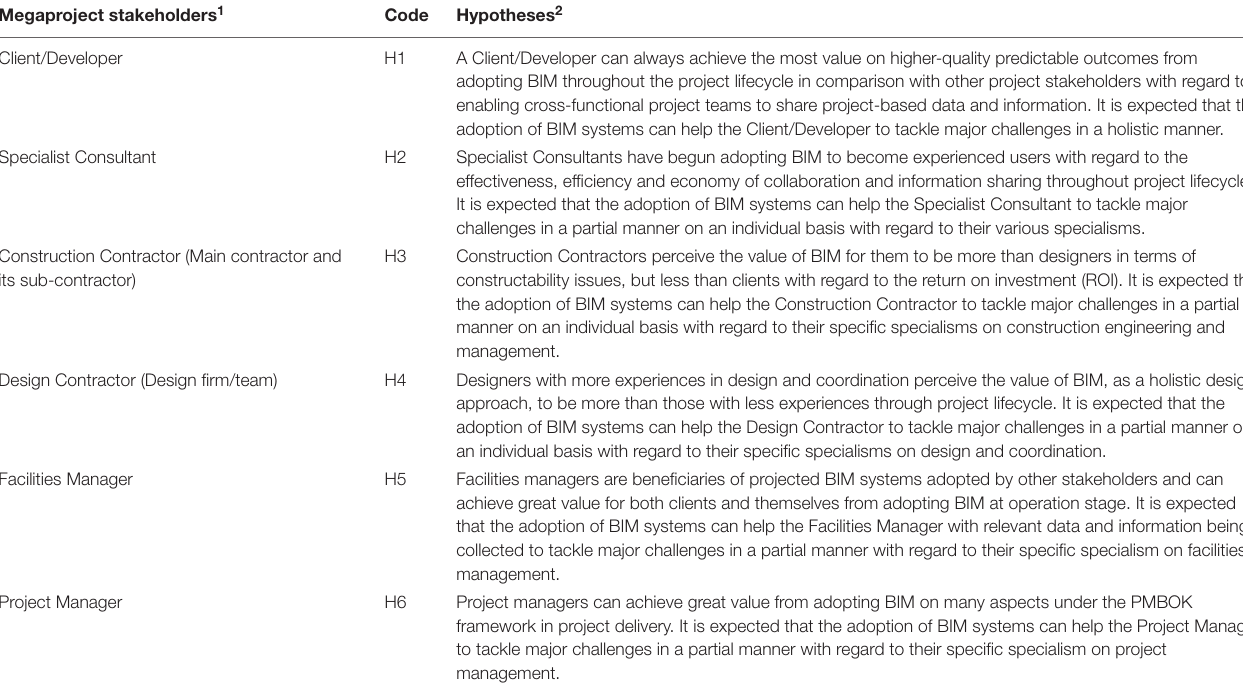
TABLE 2 | Hypotheses on megaproject stakeholders’ experiences on BIM and its key